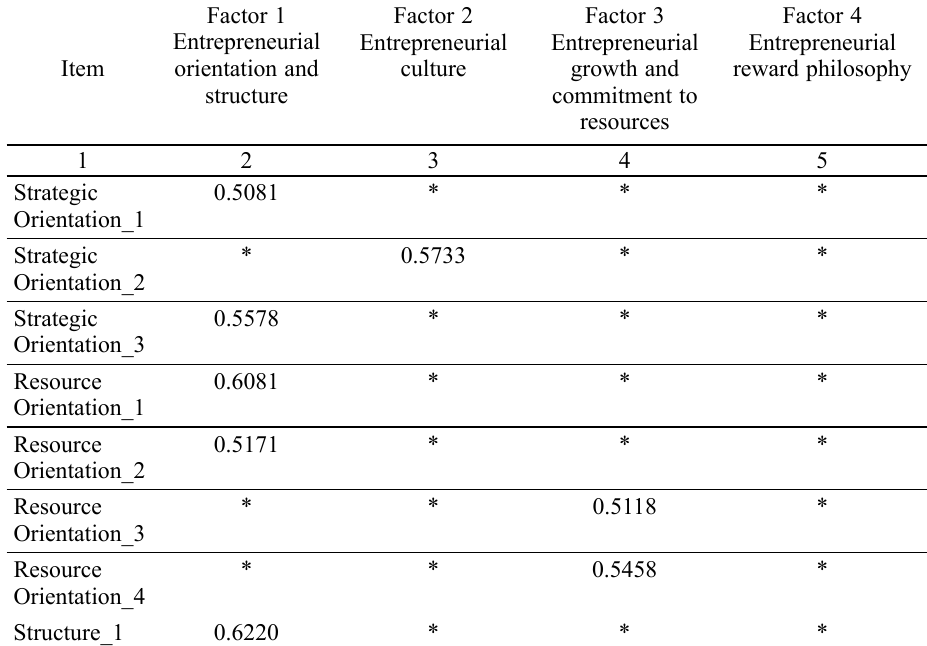
Factor 2 Entrepreneurial culture